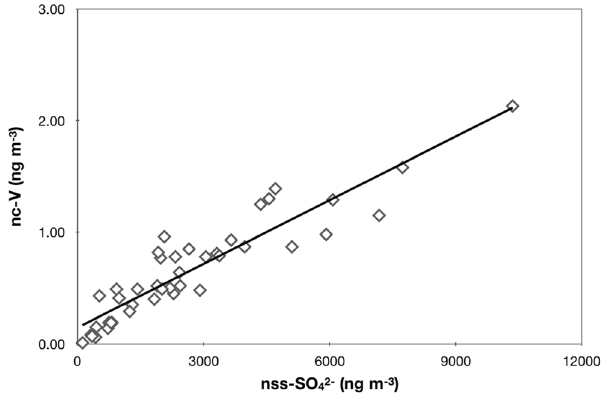
Figure 4. Scatter plot of nss-SO 42 − versus nc-V (noncrustal vanadium). See text for the calculation of noncrustal fraction. The R 2 and p -values are 0.86 and < 0.001,